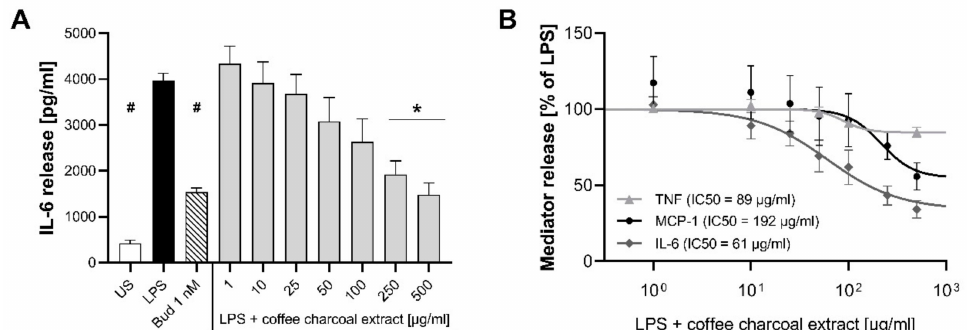
Figure 2. E ff ects of co ff ee charcoal extract (1–500 µ g / mL) on LPS-induced inflammatory mediator release from THP-1 macrophages. ( A ) Absolute IL-6 release; ( B ) concentration response curve for the inhibition of TNF, IL-6, and MCP-1 release; US = unstimulated control, LPS = LPS-stimulated and untreated control, Bud = LPS stimulation and budesonide 1 nM. Mean ± standard error of the mean (SEM), n = 9–11, # p < 0.001, * p < 0.01 compared to LPS in an ordinary one-way ANOVA.